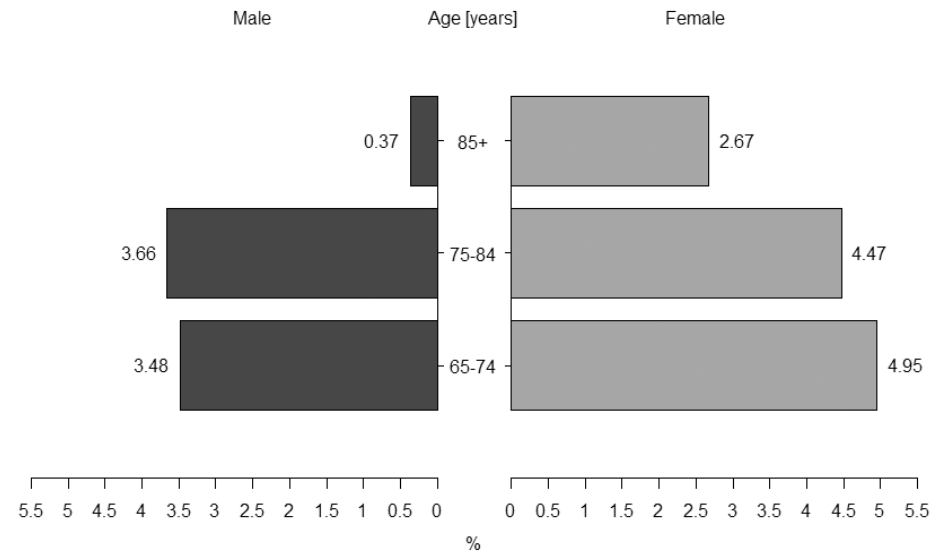
Figure 2. Percentage of anti-CCP positive males and females in age-related